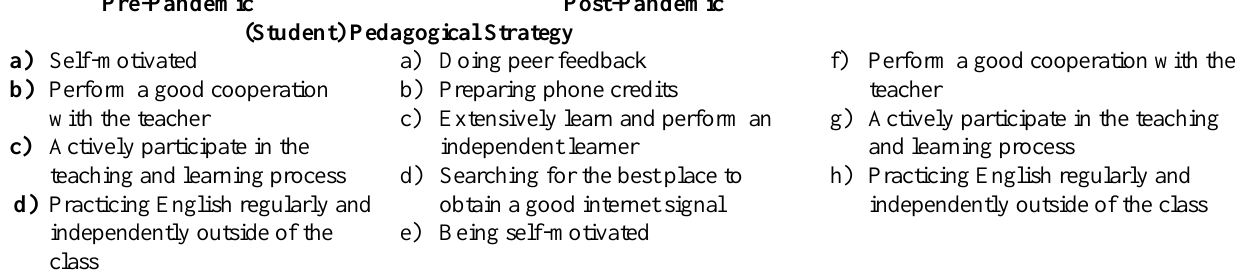
TABLE 12 | (Student) Pedagogical Strategy